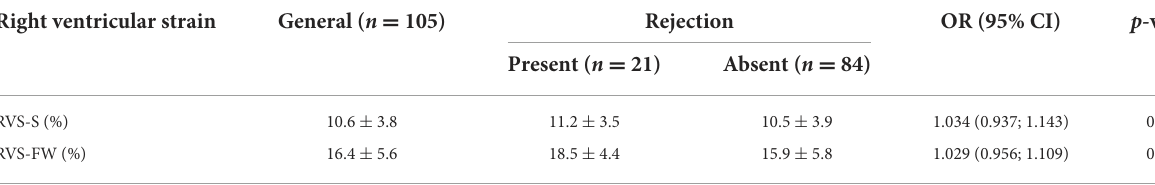
TABLE 5 Right ventricular strain, obtained by offline analysis of the three-dimensional full volume according to rejection. Right ventricular strain